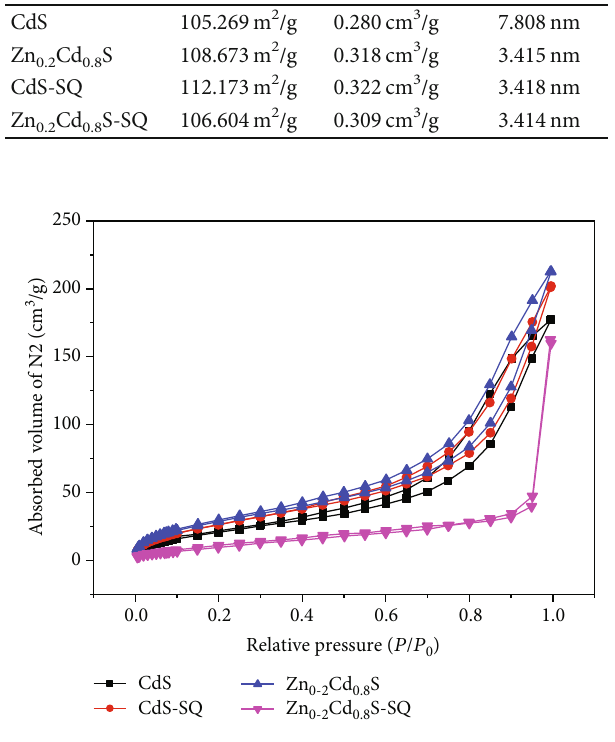
Table 2: Speci fi c surface analysis of synthesized photocatalysts. Samples